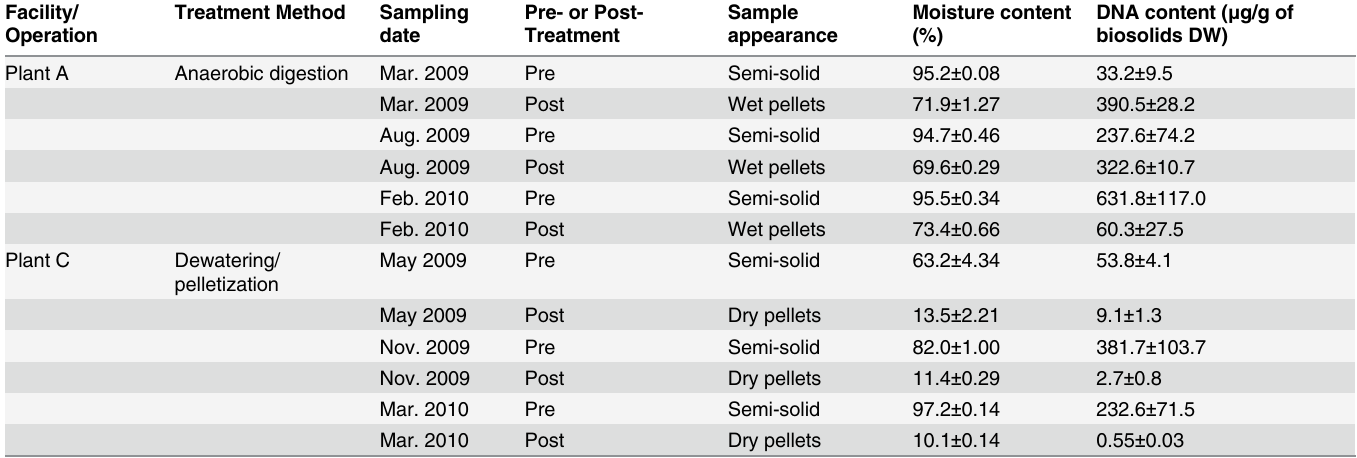
Table 1. Physical characteristics of pre- and post-treatment biosolids in two Canadian facilities. Values are mean ± SD. Facility/